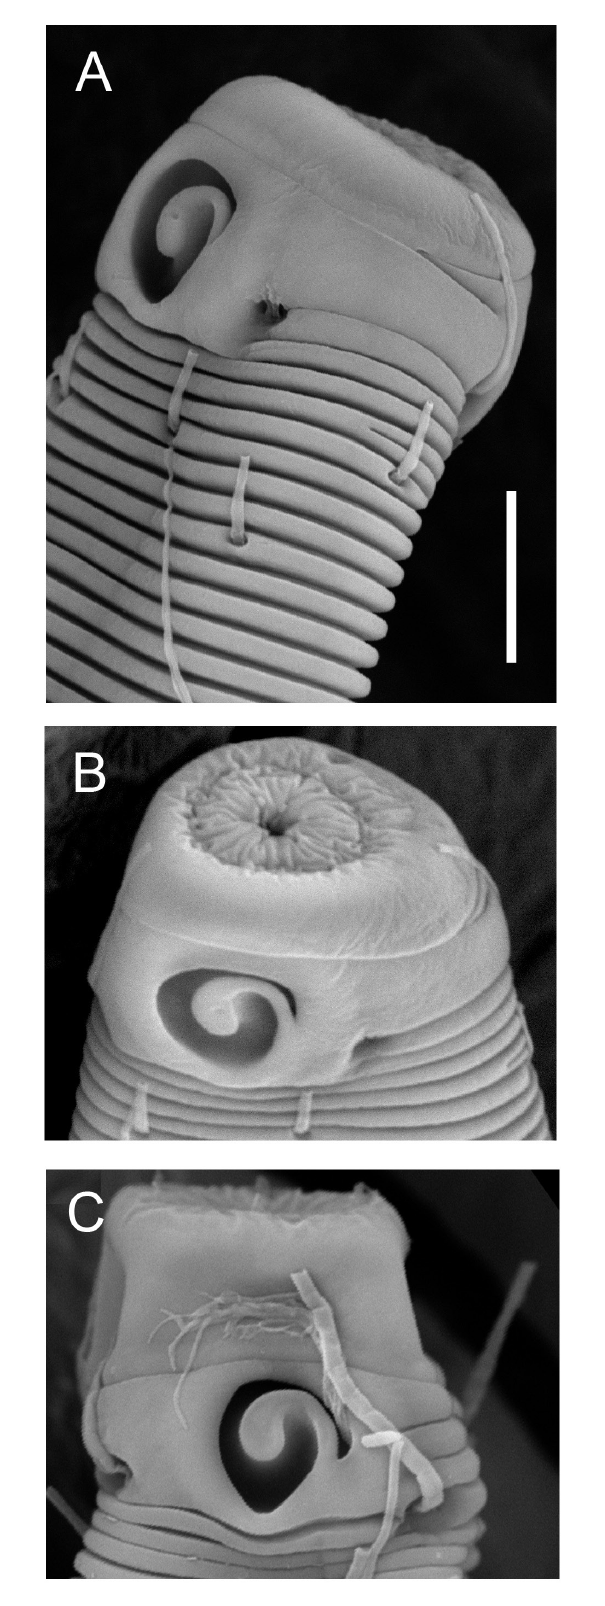
Fig. 7. Stygodesmodora confusa sp. nov. Scanning electron micrographs. Female head (three different specimens). Scale bar = 5 µ